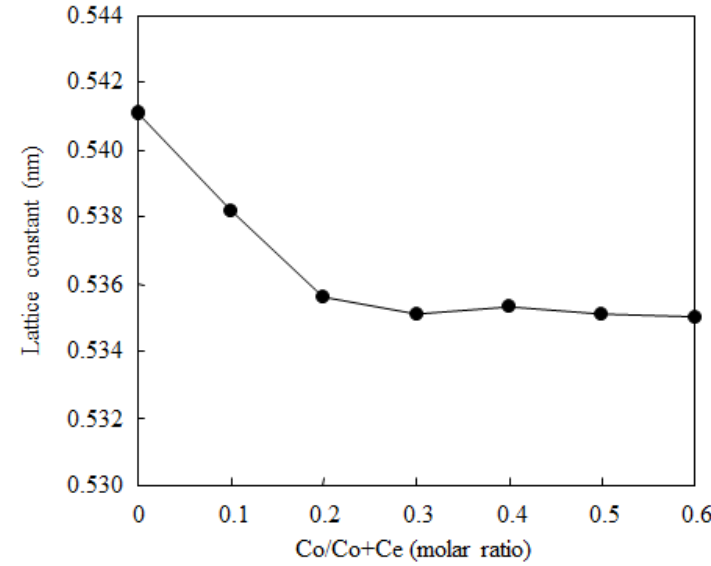
Figure 2. Lattice constant of CeO 2 in the Ce 1 − x Co x O 2 − y prepared by homogeneous precipitation after calcination at 723 K for 3 h.